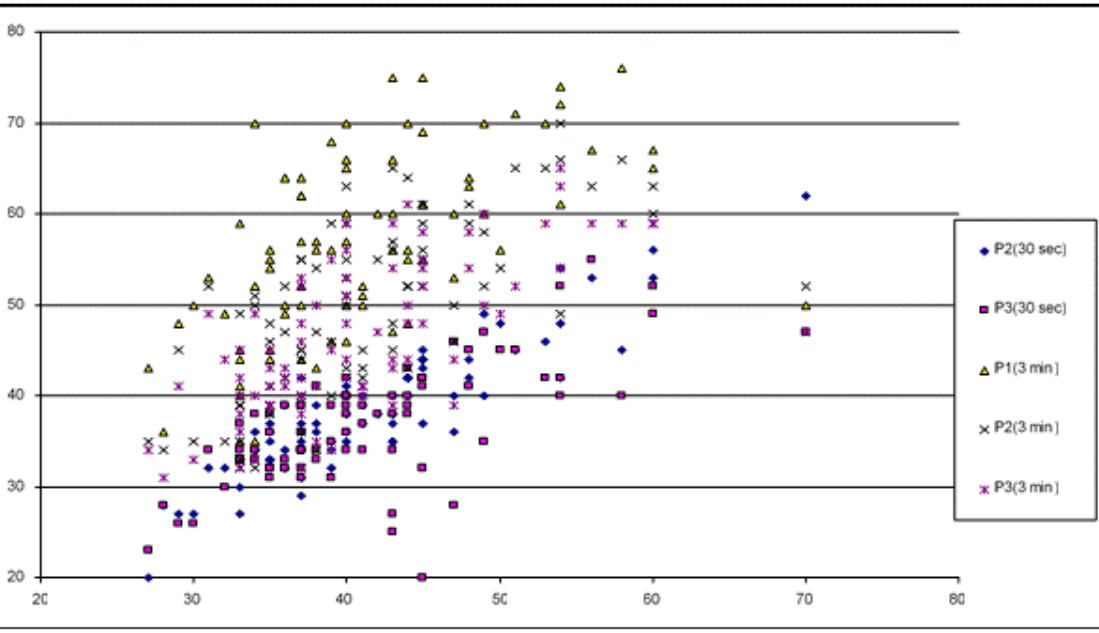
Fig.2. Correlation field of heart beats rate (HBR) measurement results’ distribution with fulfillment of 3 minutes’ and 30 seconds’ variant of Harvard